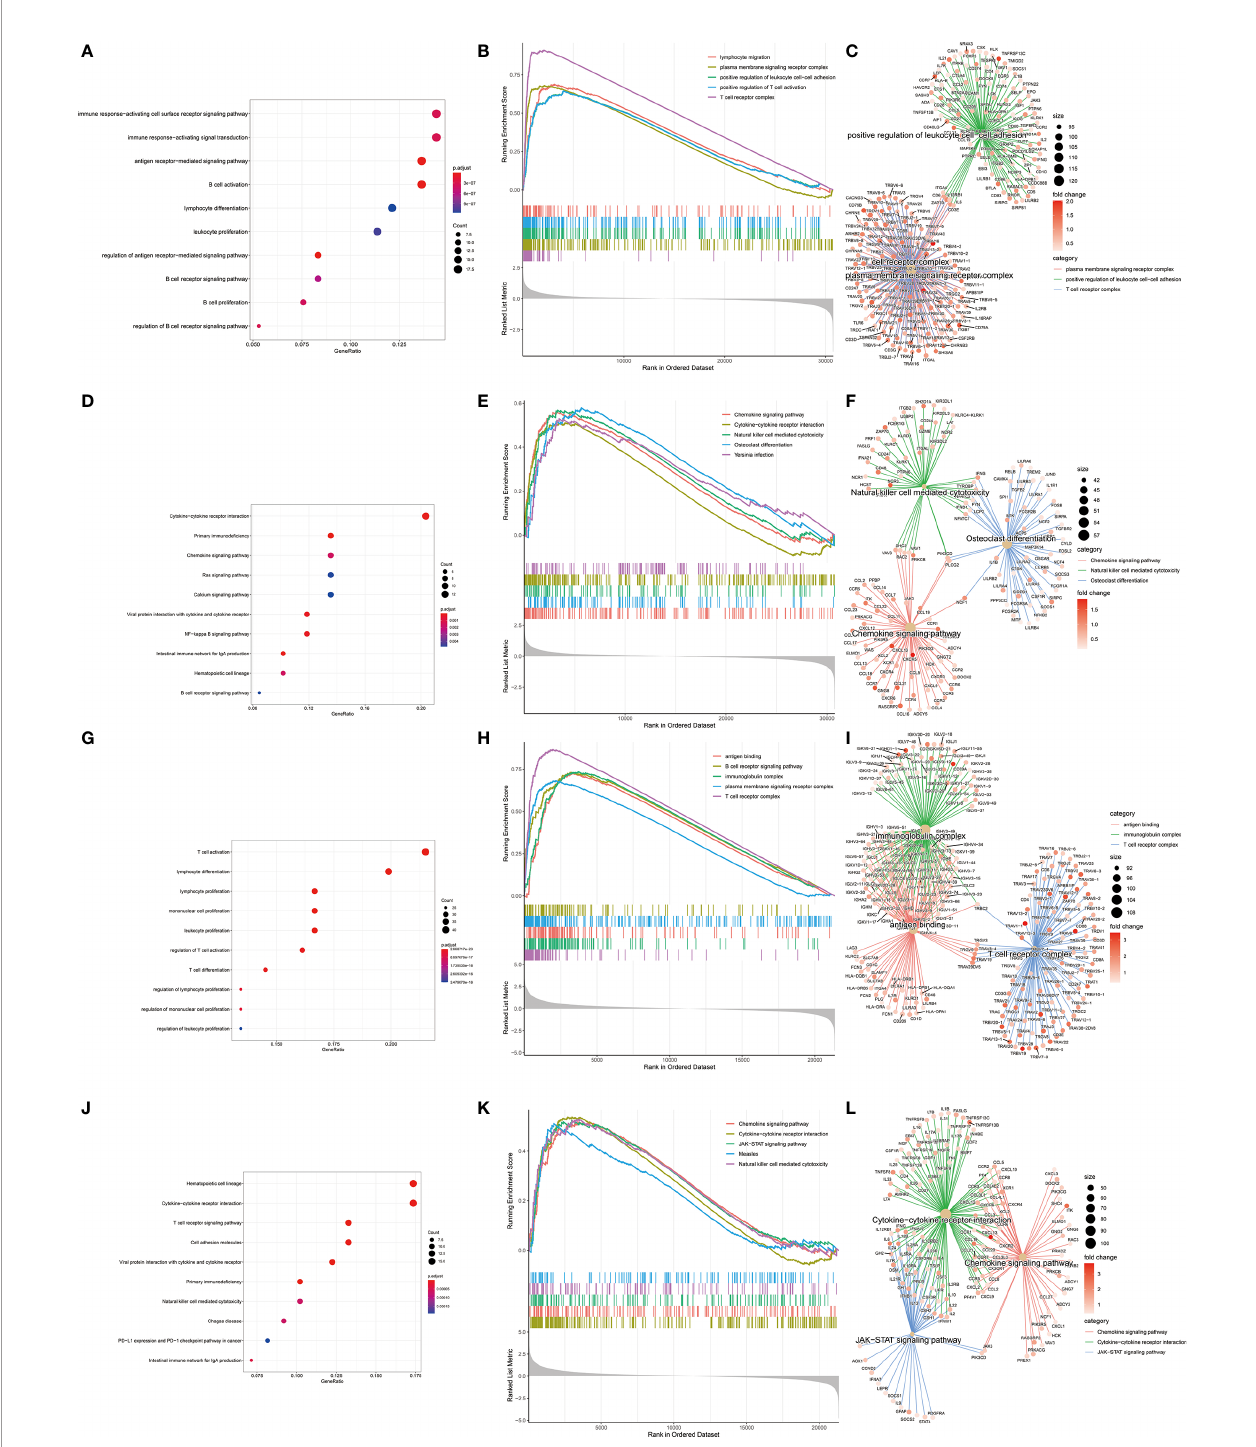
FIGURE 2 | KEGG, GEO enrichment analysis of upregulated genes in diabetic pancreatic cancer patients and GSEA results. (A – C) Functional enrichment of GO overexpressed genes, GSEA and gene regulatory networks in the TCGA PAAD dataset, respectively. (D – F) Functional enrichment of KEGG overexpressed genes, GSEA and gene expression regulatory network in TCGA PAAD dataset, respectively. (G – I) Functional enrichment of GO overexpressed genes, GSEA and gene expression regulatory network in the GSE79668 dataset, respectively. (J – L) is the functional enrichment of KEGG overexpressed genes, GSEA and gene expression regulatory network in the GSE79668 dataset,